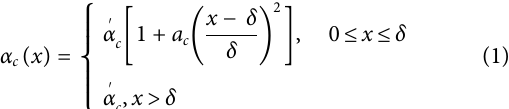
Frontiers in Materials |